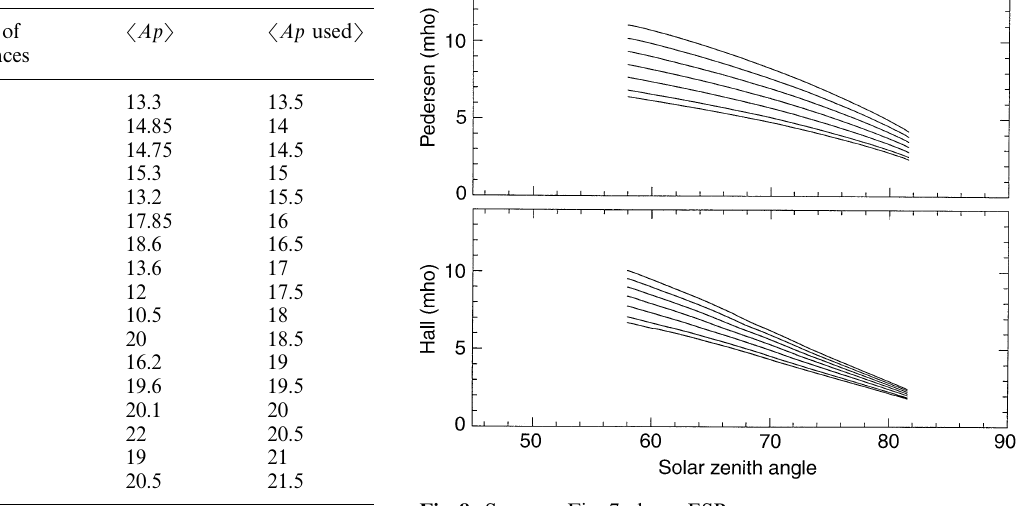
Table 2. Variation of the Ap index versus f (cid:49)(cid:48)(cid:46)(cid:55)